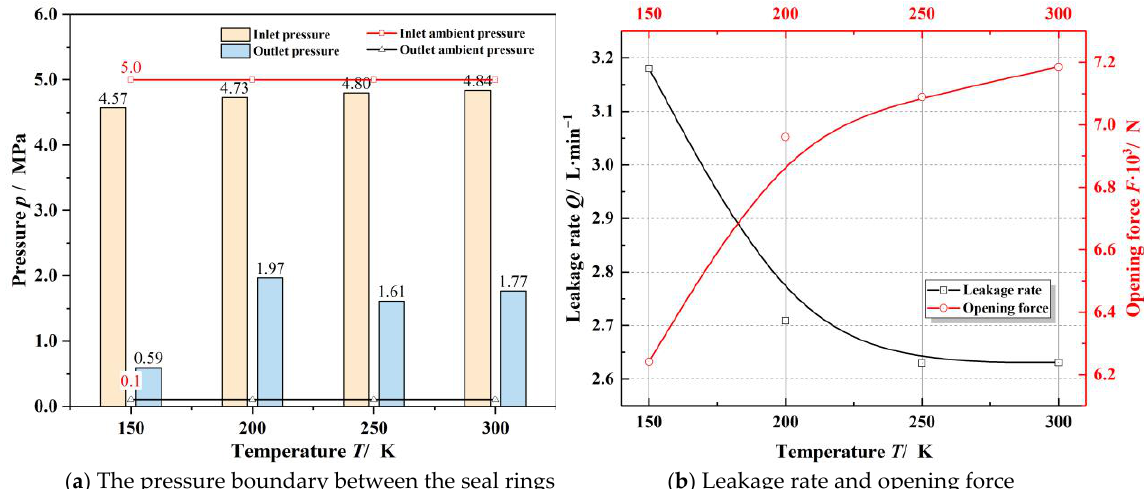
Figure 7. Variation of sealing performance under different sealing ambient temperature ( h 0 = 3.0 μm, ω = 20,000 r·min −1 , p o = 5.0 MPa).